Question: Reading the figure, is the described quantity rising or falling?
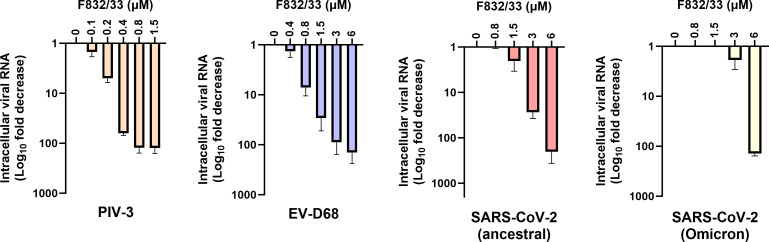
Answer: increasing